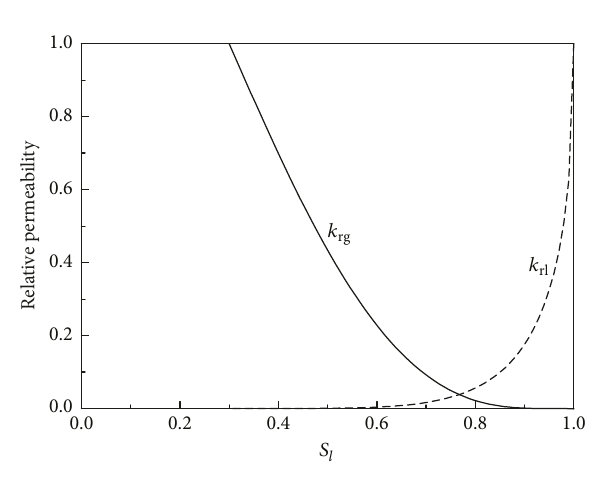
Figure 6: Capillary pressure curve.